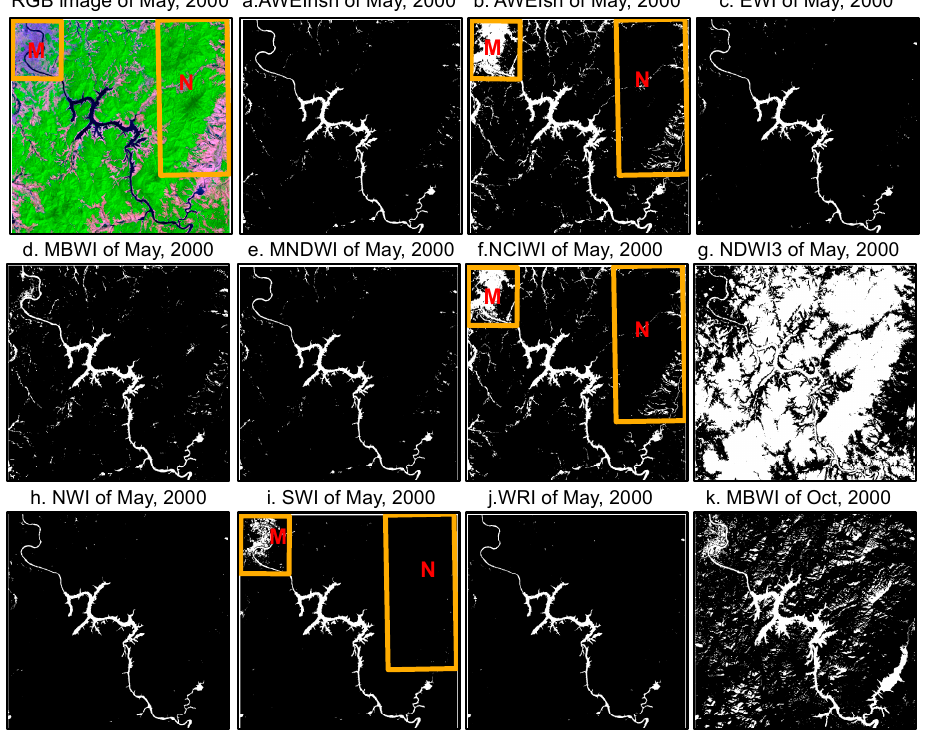
Figure 14. RGB (band 752 in Table 1) image and water extraction maps of the study area of Songhua Lake based on the AWEInsh ( a ), AWEIsh ( b ), EWI ( c ), MBWI ( d ), MNDWI ( e ), NCIWI ( f ), NDWI3 ( g ), NWI ( h ), SWI ( i ) and WRI ( j ) of May 2000 and on the MBWI ( k ) of October 2000 with their optimal segmentation thresholds. The orange boxes and the red uppercase letters on the maps within the box (M and N) are used to mark the typical regions where CE or OE occurs.